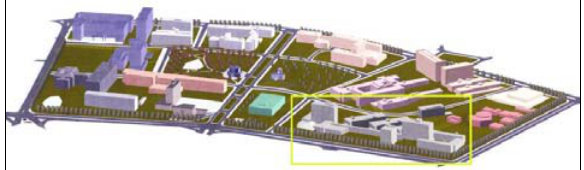
Figure 1: The University campus and the Faculty of Engineering (in yellow